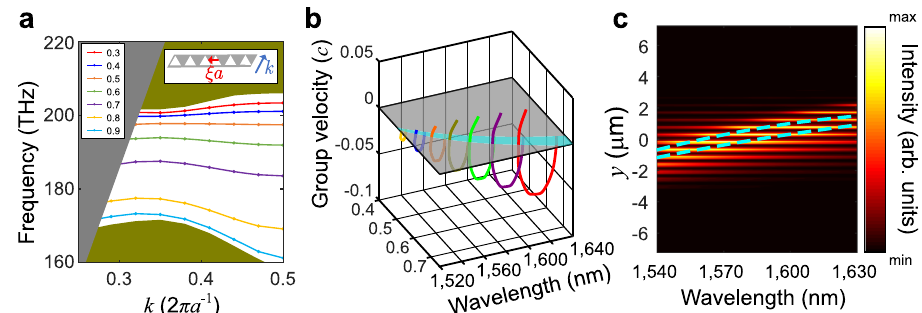
Fig. 2 Bands and group velocities of the interface states. a The interface bands of TE-like modes. The grey domain denotes the light cone, and the greyish-green domain denotes the projected bulk bands. The inset shows the supercell of the spliced structure, where the grey part is silicon fi lm and the white triangles are holes. The translational parameter (red arrow) and the wavevector (blue arrow) along the interface are marked. b Group velocity as a function of parameter ξ and wavelength. The colored lines are group velocity lines for ξ = 0.52, 0.55, 0.58, 0.61, 0.64, 0.67, and 0.70, respectively. The zero-group-velocity plane is marked by the grey plane. The cyan region denotes the projection of group velocity lines. c Calculated results of interface intensity for different incident wavelengths. The green dashed lines mark the boundaries of the projected interface bands, where the dimension ξ is substituted by the coordinate